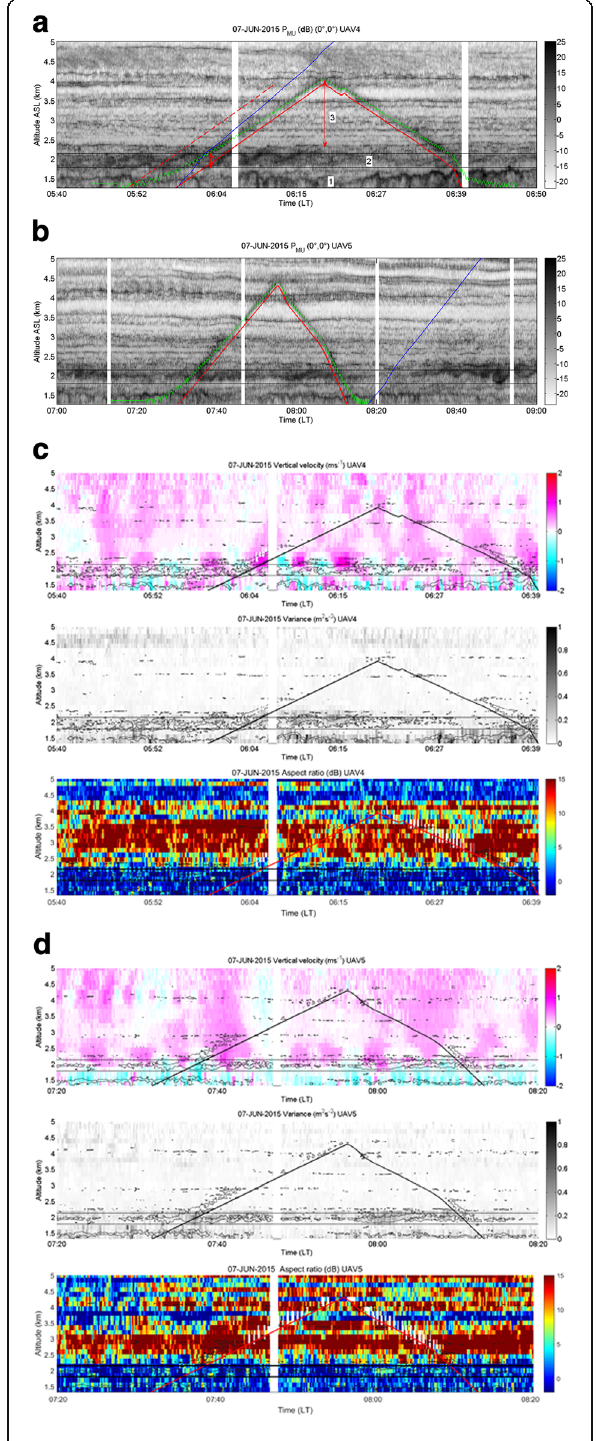
Fig. 2 Horizontal trajectories of B1 (black line), B2 (gray line), and the UAVs (black circles at the bottom of the figure). The red (green) arrow shows the mean wind (shear) vector in the KH region (2) according to B1 data and scaled by 250. The variations of the wind shear scaled by 25 in the KH region (2) are given by the short green arrows. The dashed lines show the expected billow crest axes assumed to be perpendicular to the wind shear